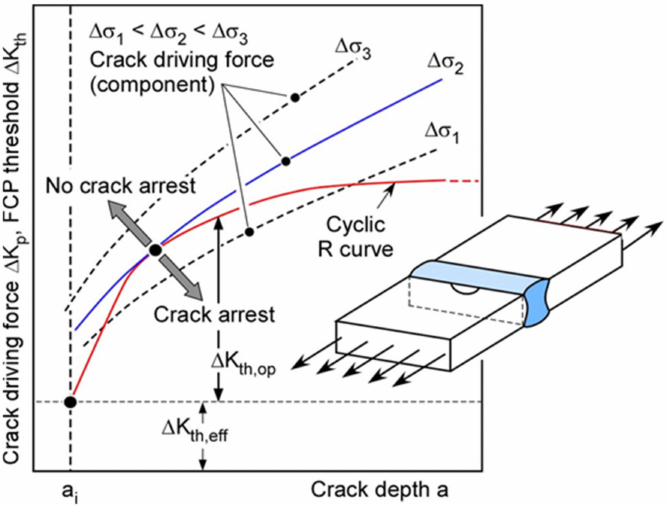
Figure 10. Principle of a cyclic R curve analysis to determine the fatigue limit based on crack